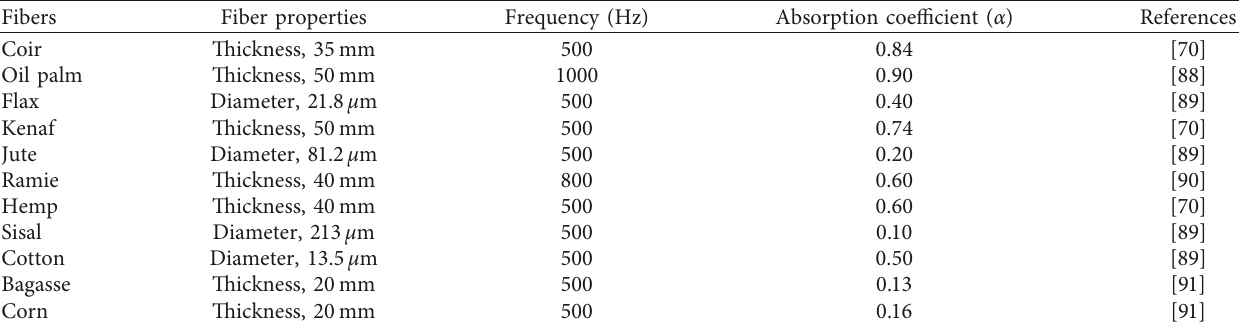
Table 11: Acoustical absorption coefficient of natural